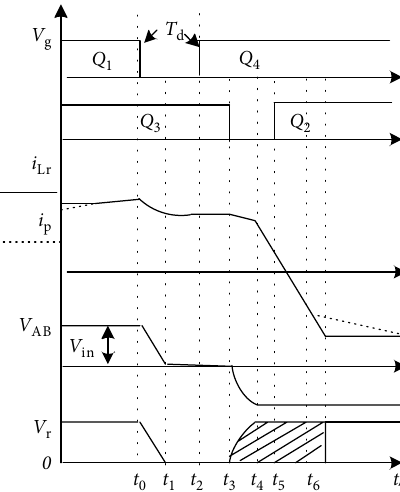
Figure 7: Digital peak current control system.